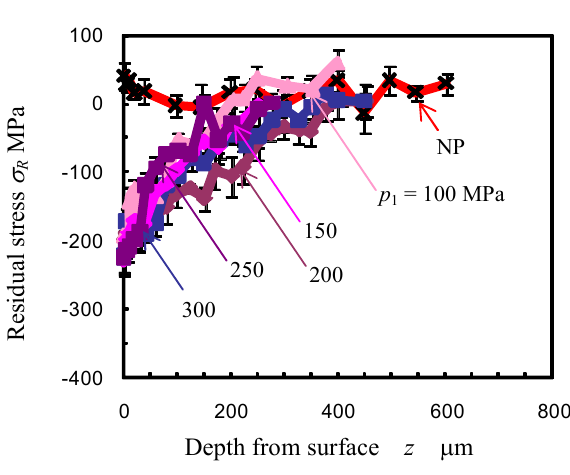
Fig. 11 Variation of residual stress with depth ( d = 0.35 mm, p = 0.1 MPa, t = 1 s/mm) 2 p MPa is -220 ± 30 MPa. The depth of the modified layer with p = 30 MPa is about 1000 µ m 1 and that with p = 300 MPa is about 300 µ m. Thus, we conclude that the compressive 1 residual stress introduced by a large jet with low injection pressure is better than that by a small jet with high injection pressure for the same jet power. In this paper, the nozzle shape for p = 30 MPa and 300 MPa was different. It was reported that the jet through the nozzle 1 diameter d = 0.55 mm ( p = 100 MPa) can introduce large compressive residual stress than 1 that of d = 0.35 mm ( p = 300 MPa) using similar nozzle geometry (36) . The one of reason 1 why a large jet with low injection pressure can introduce larger compressive residual stress than that of a small with high injection pressure is that above mentioned the effect of cavitation number. The other reason is that the large jet can produce large impacts due to scaling effect of cavitation (37) . The enhancement of the jet due to the effect of cavitation number and the scaling effect is larger than that of the injection pressure.